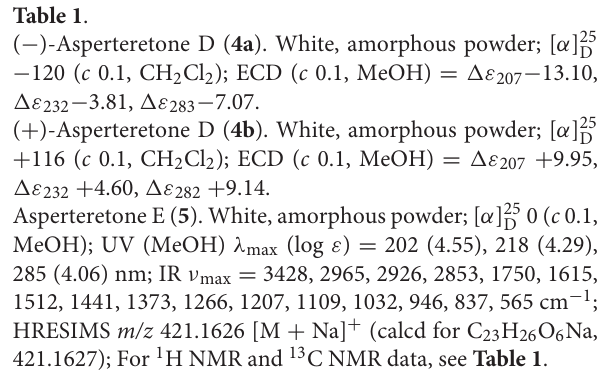
( )-Asperteretone D ( 4a ). White, amorphous powder; [ α ] 25 −